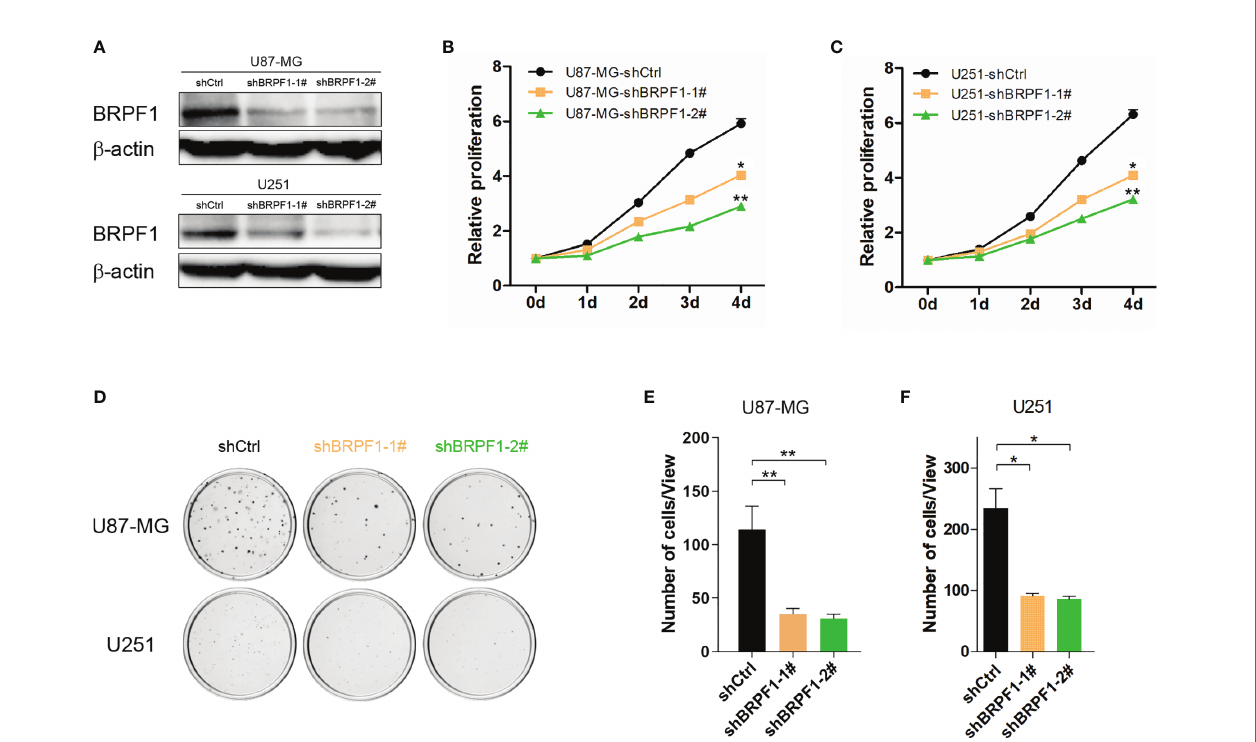
FIGURE 8 | Knockdown of BRPF1 expression weakened glioma cell proliferation and colony formation. (A) The protein levels of BRPF1 were detected by western blot in U251 and U87-MG cells. Proliferation of U87-MG (B) and U251 (C) cells with knockdown of BRPF1 expression was tested by CCK-8 assays. Colony formation assay of U87-MG and U251 cells with knockdown of BRPF1 expression for three weeks (D) and the number of cell clones (E, F) . *p < 0.05; **p < 0.01, two-tailed unpaired